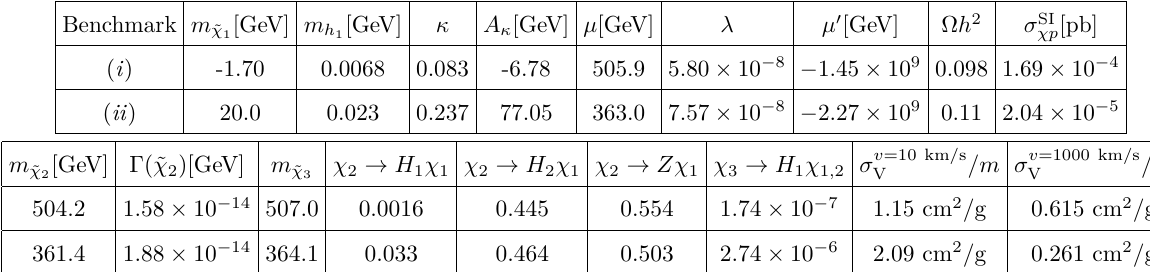
Table 2 . Two benchmark points in the SIDM scenario of the NMSSM. Both points pass the preselections, address the small scale structure problem and provide correct DM relic density. The benchmark point ( i ) also evade all current DM direct searches while the second one is not.